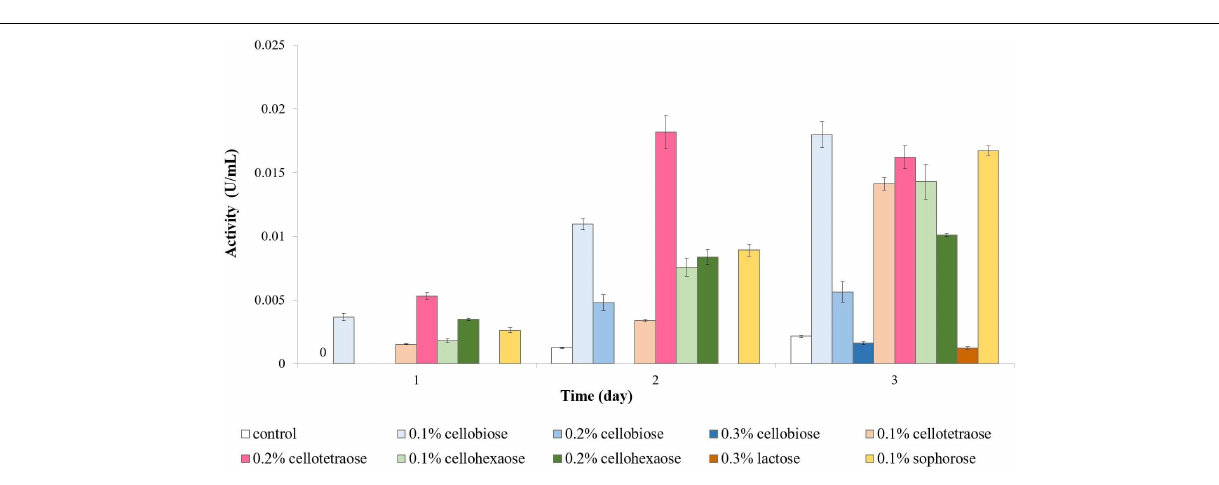
Frontiers in Microbiology |